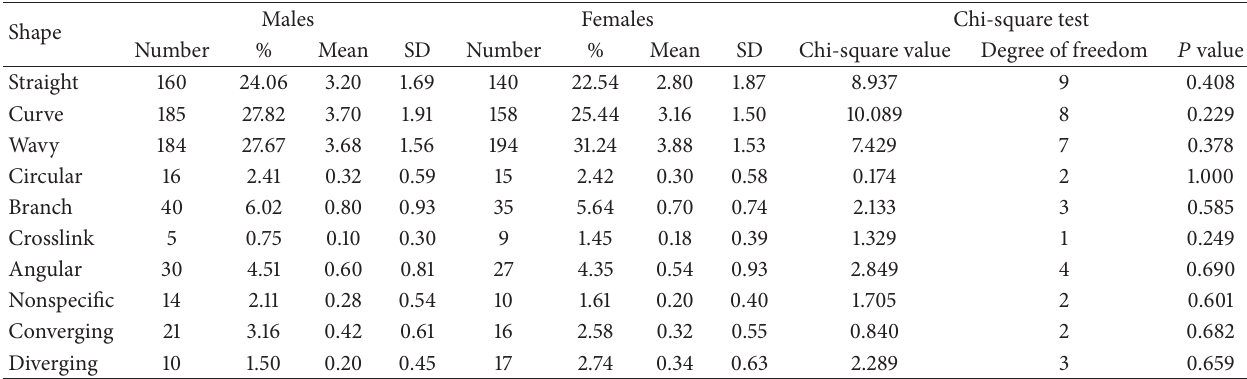
Table 2: Descriptive statistics for palatal rugae shapes in both sexes.